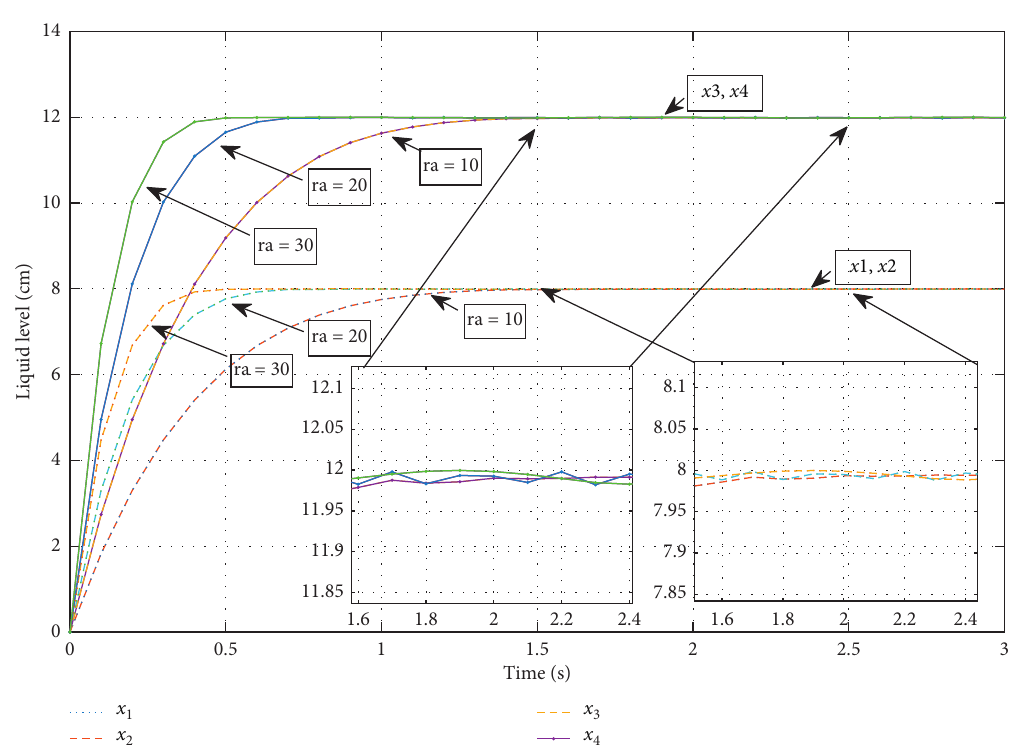
Figure 2: Liquid levels under the finite-time control law with ra � 10 , 20 ,